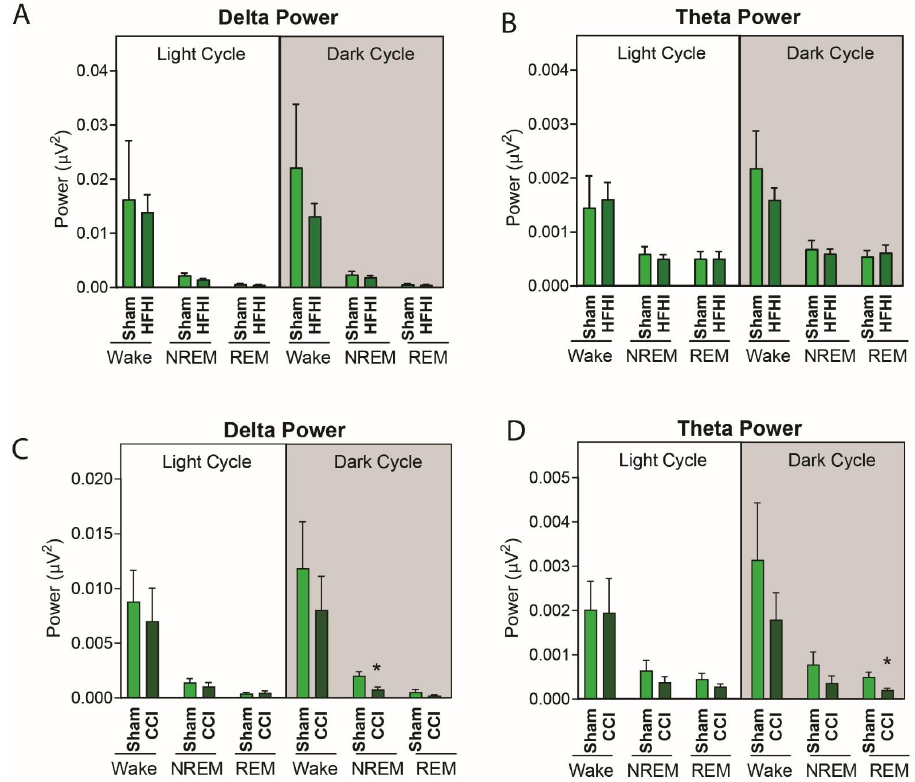
7 Figure 6. CCI, but not HFHI, alters slow wave sleep at 7 d post-injury. HFHI and CCI mice were